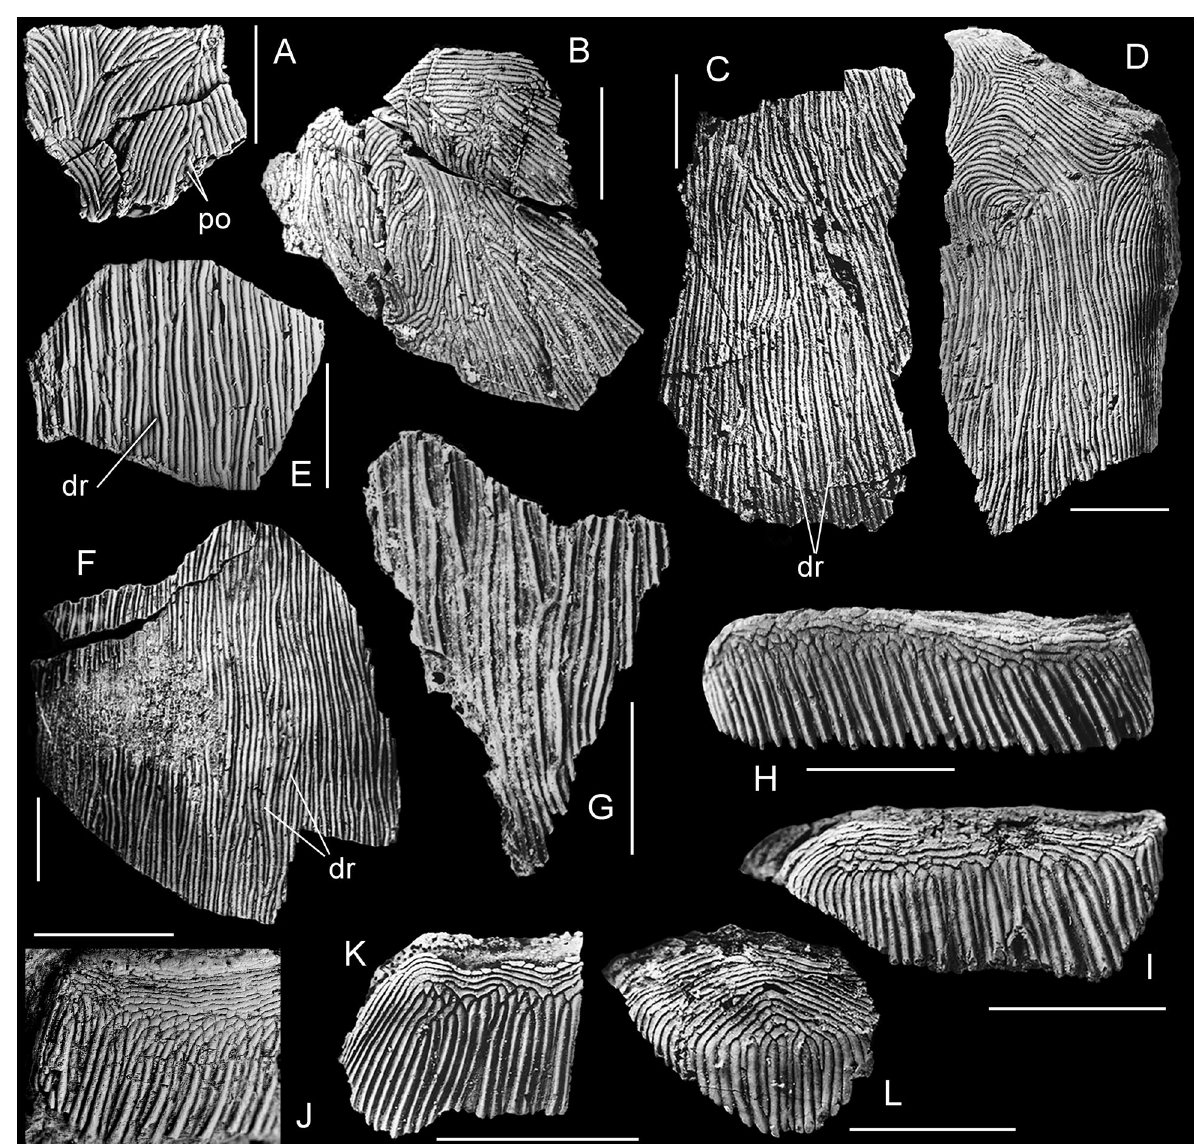
Fig. 5. Archegonaspis integra (Kunth): fragments of the dorsal and ventral side of the shields, and the scales: A , small fragment from the right side of the dorsal shield (partial rostral, central and ?lateral epitega), GIT 408-3; B , fragment from anteriorly of the right side of the dorsal shield, GIT 408-7; C , big fragment of the middle and right portions of the dorsal shield, GIT 408-6; D, left side of the ventral shield broken posteriorly, GIT 408-2; E , F , the position of these fragments on the body is unclear, possibly the ventral shield, GIT 408-4 and GIT 408-5, respectively; G , the position of the fragment on the body may be dorsal, GIT 408-8; H–K , dorso-lateral scales: H, GIT 408-39; I, GIT 408-41; J, GIT 408-38; K, GIT 408-40; L , ventro-lateral scale, GIT 408-42. Scale bars = 3 mm. Locations : A–E, G–L, locality 85-042; F, locality 85-146-5D, Tabuska (Vishnevaya Gora) section, the Central Urals, Tabuska Beds either of the lower P ř idoli (Shujskij 1981; Shurygina et al. 1981) or upper Ludlow level (Modzalevskaya & Märss 1991). Abbreviations : dr, double-ridge; po, pores of lateral line